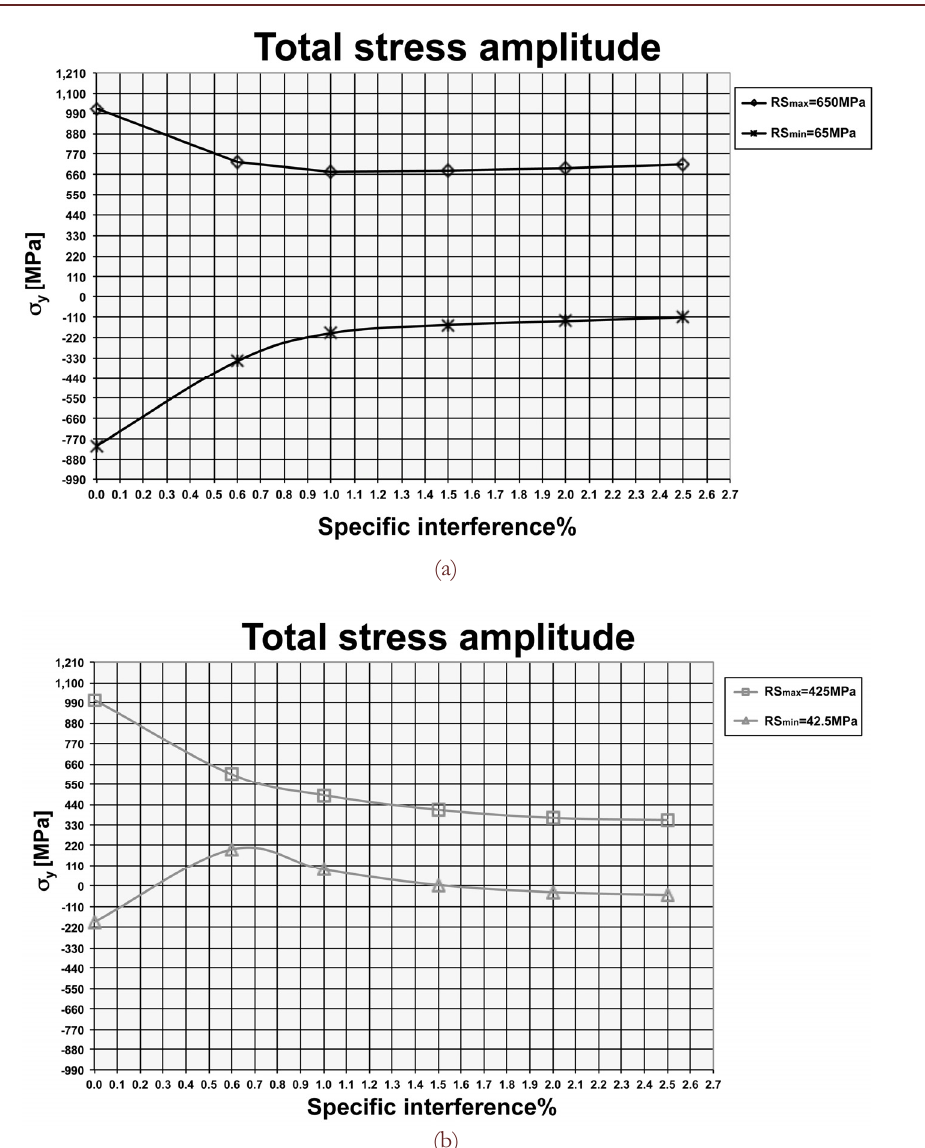
Figure 7: Stress amplitude